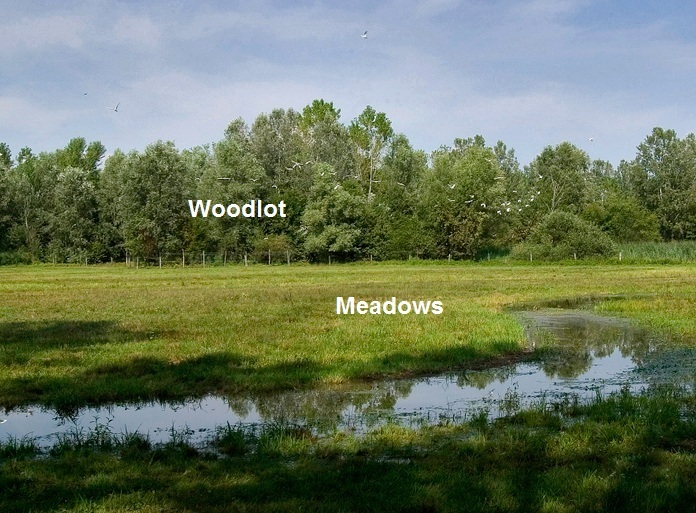
Wet meadow with reforested area on the background.